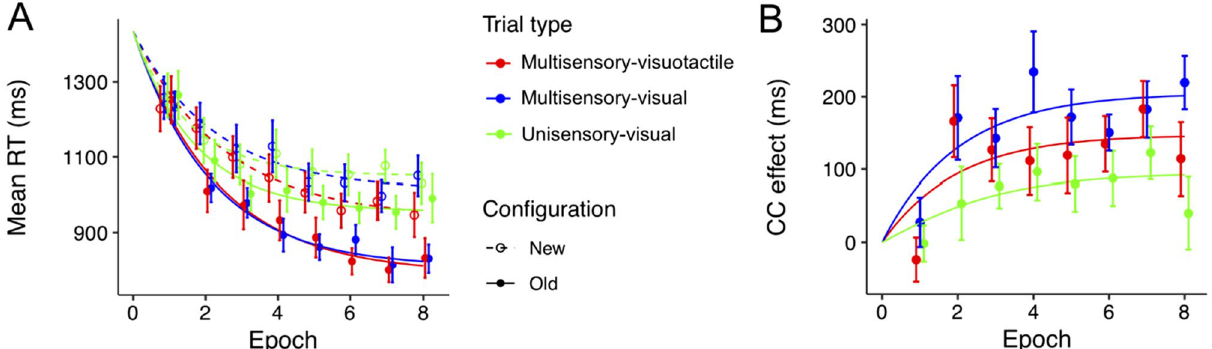
Figure 5. Mean contextual-cueing effects and exponential modeling results. ( A ) Mean RTs for old and new configurations in the three trial-type conditions across epochs (one epoch collapses the RT data across 4 consecutive blocks). The curve represents two-parameter exponential, i.e., power-function fits to the data (see text for explanation). Error bars depict the standard errors of the means (SEM) . ( B ) Mean contextual cueing (CC) effects as a function of epoch in the three trial conditions: unisensory-visual, multisensory-visual, and multisensory-visuotactile (green, blue, and red lines, respectively). The subtraction curves ‘old minus new configurations’ for the three trial types (see the corresponding color-coded curves in ( A ) are depicted along with the mean contextual-cueing effects indicated by the individual data points. Note that the fitting of the curves depicted in Fig. 5B was constrained by the (psychological) assumption that there would not be any (acquired) contextual-cueing effect at the beginning of the experiment (i.e., Epoch 0). The fit of model was assessed using the normalized Root Mean Square Error (RMSE), also referred to as the scatter index (SI): SI = (RMSE/ average observed value)*100%. The values of SI turned out to be 2.6%, 3.6%, and 4.4% for unisensory-visual, multisensory-visual, and multisensory-visuotactile trials, respectively. Thus, the fit is good for all three conditions, though slightly better for unisensory-visual trials because of the above-mentioned constraint for Epoch